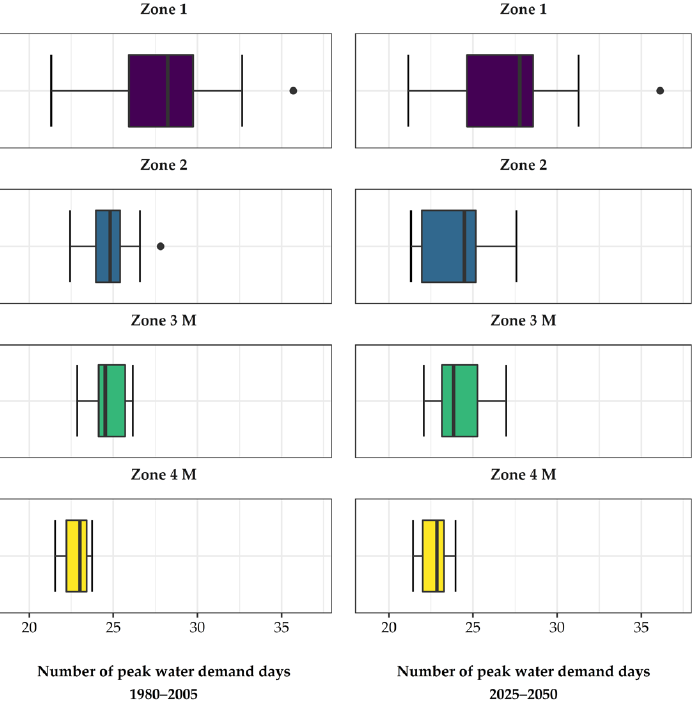
Figure 7. Number of peak water demand days. The left side shows the number of peak water demand days for the reference period (1980–2005). The right side shows the number of peak water demand days for the time period 2025–2050. The bandwidth of the depicted values results from 16 different climate